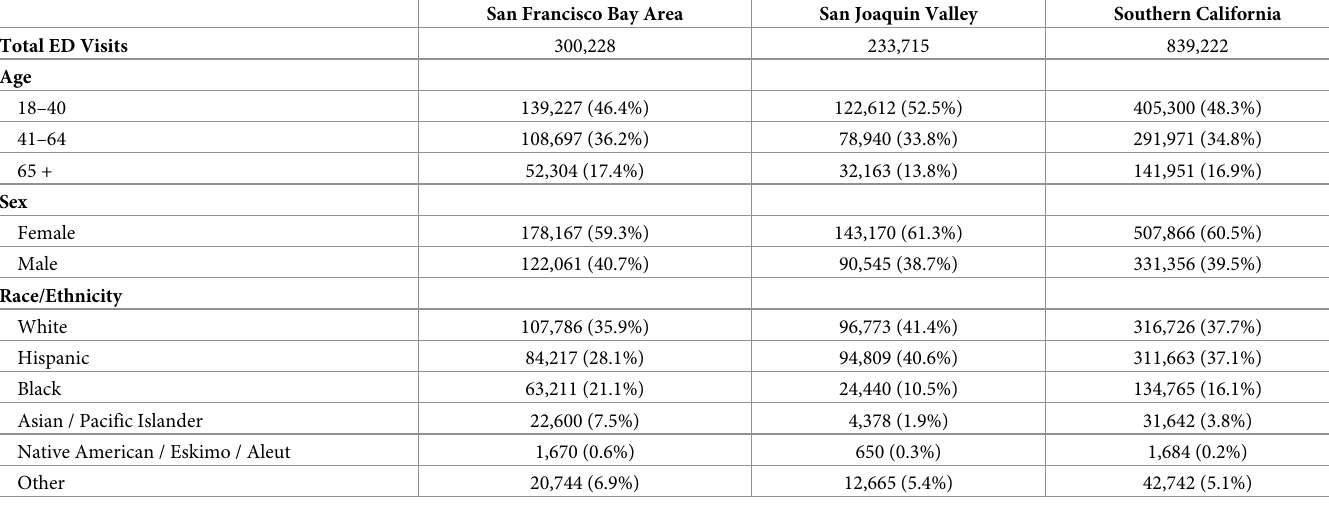
Table 1. Demographics of study population observed from 2012–2014 in three regions of